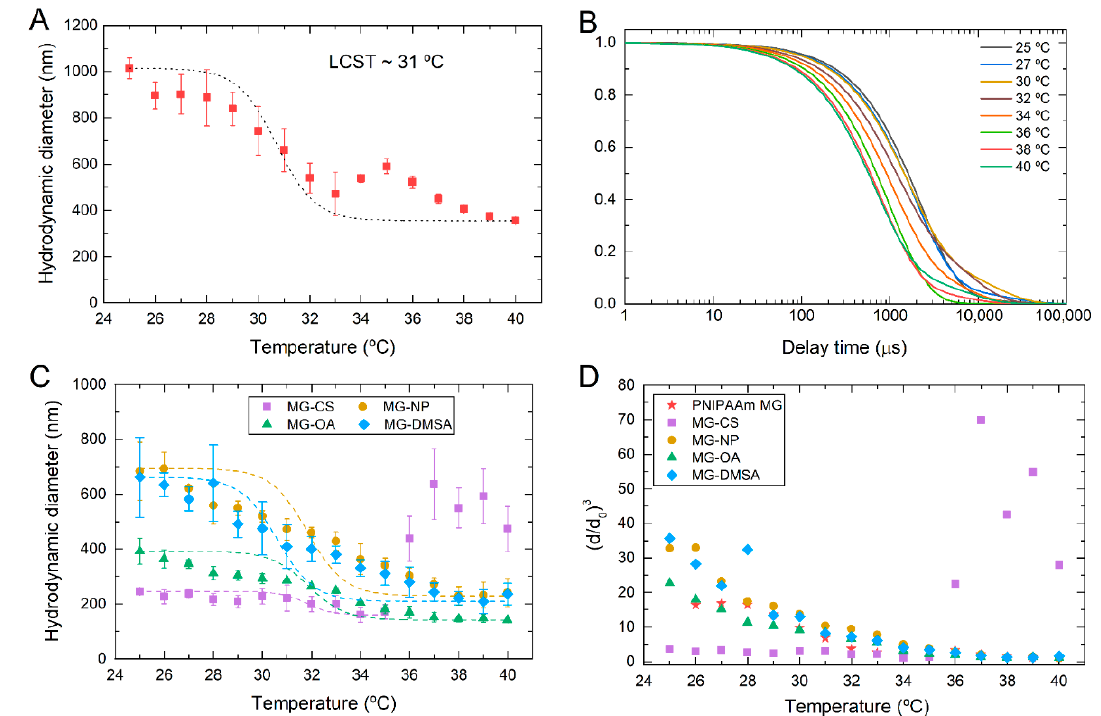
Figure 4. ( A ) Hydrodynamic diameter (D H ) of PNIPAAm microgels as a function of temperature, and the corresponding autocorrelation curves ( B ), denoting a Lower Critical Solution Temperature (LCST) around 31 °C. ( C ) Hydrodynamic diameter of composite PNIPAAm microgels as a function of temperature; ( D ) Relative swelling index ((d/d 0 ) 3 ) as a function of temperature of plain PNIPAAm microgels and composite microgels. (MG-CS: PNIPAAm microgels with chitosan; MG-NP: PNIPAAm microgels with bare Fe 3 O 4 NPs; MG-OA: PNIPAAm microgels with Fe 3 O 4 NPs coated with oleic acid; MG-DMSA: PNIPAAm microgels with Fe 3 O 4 NPs coated with dimercaptosuccinic acid).